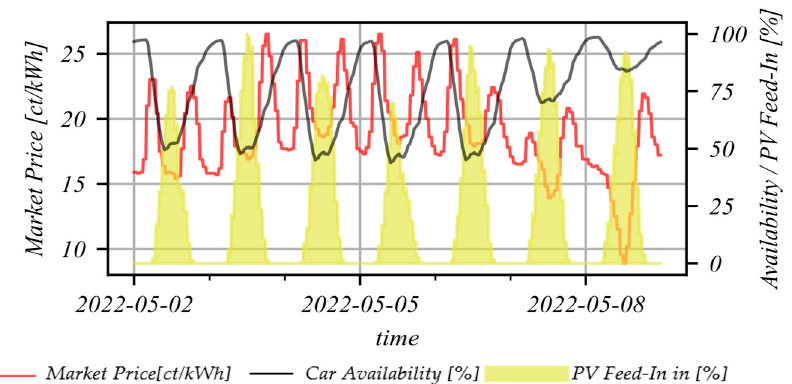
Figure 6. Spot market prices + percentage of PV feed-in in contrast to the car availability.